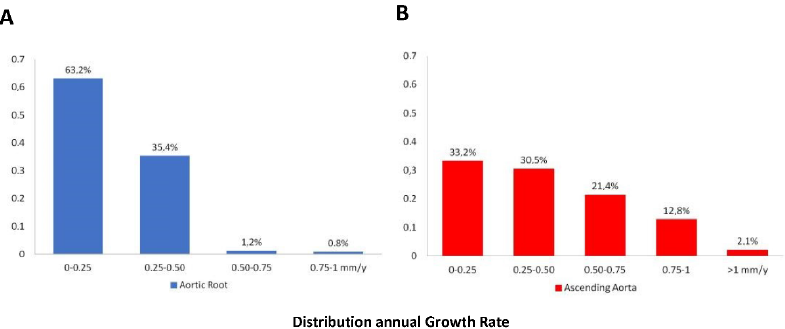
Figure 1. Histograms showing the distribution of mean annual growth rates of aortic root ( A ) and ascending aorta ( B )